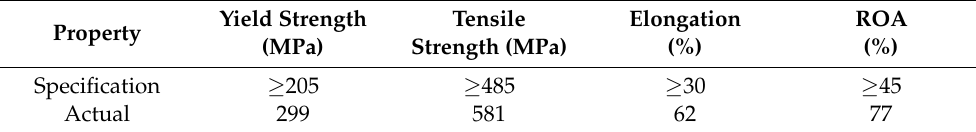
Table 5. Tensile properties of the stainless steel tube.